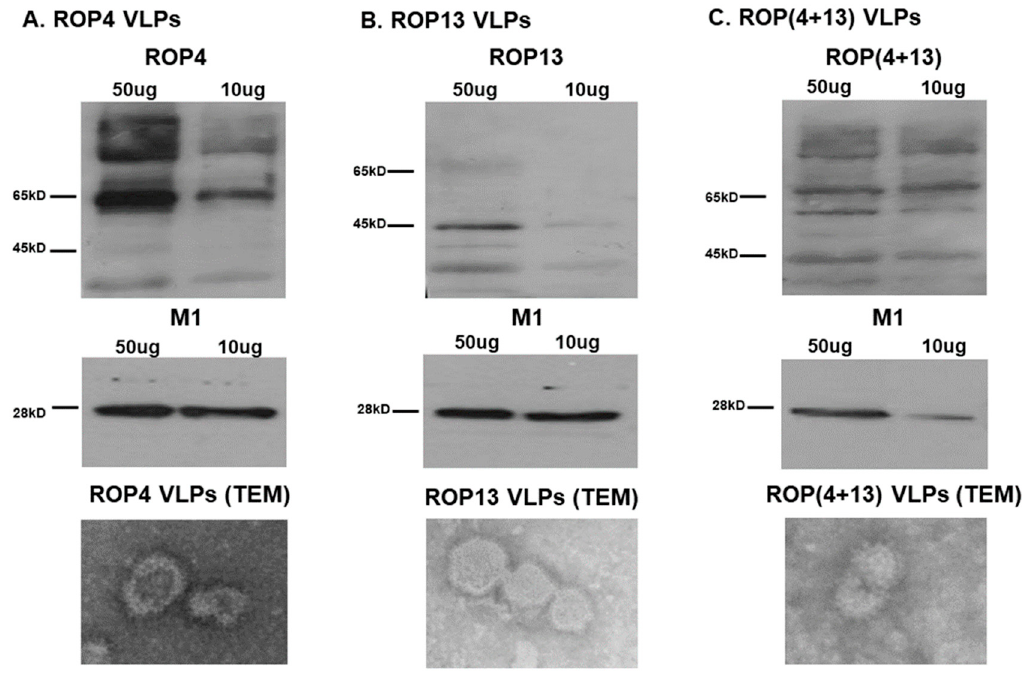
Figure 1. Characterization of virus-like particles (VLPs). The 50 and 10 µ g of VLPs were loaded for SDS-PAGE and visualized by western blot. As shown in ( A ), ROP4 VLPs containing ROP4 proteins and M1 ( A ) were detected. Similarly, ROP13 VLPs containing ROP13 proteins and M1 ( B ) were also detected. In case of ROP(4 + 13) VLPs, the presence of ROP4, ROP13 proteins and M1 ( C ) were confirmed. TEM was used to confirm the shape of ROP4 VLPs ( A ), ROP13 VLPs ( B ) and ROP(4 + 13) VLPs ( C ).